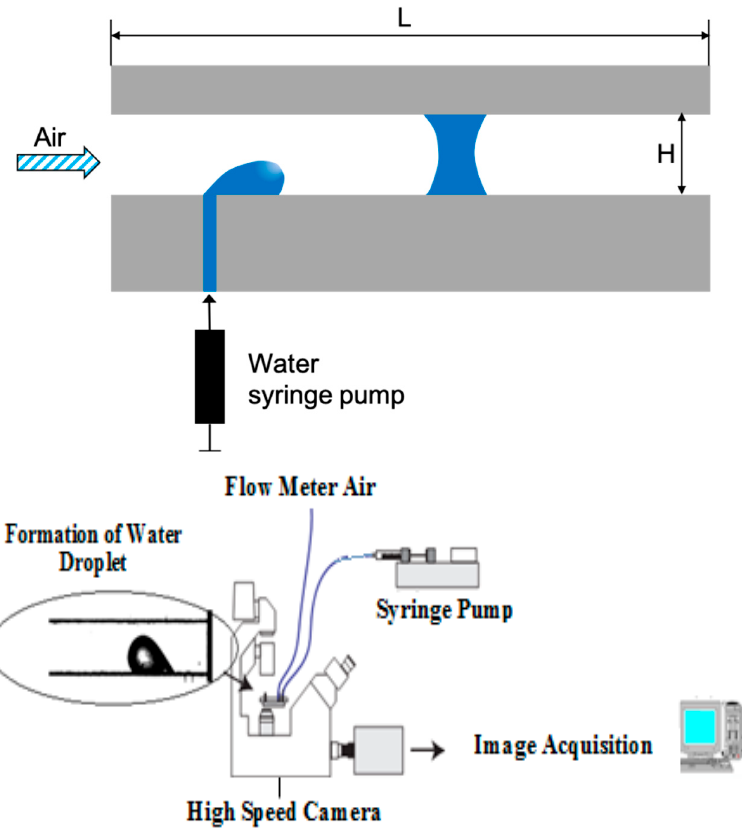
Figure 2. Experimental setup: schematic of water injection into microchannel and formation of water droplet and capillary bridge ( Top ); flow control and data acquisition ( Bottom ).